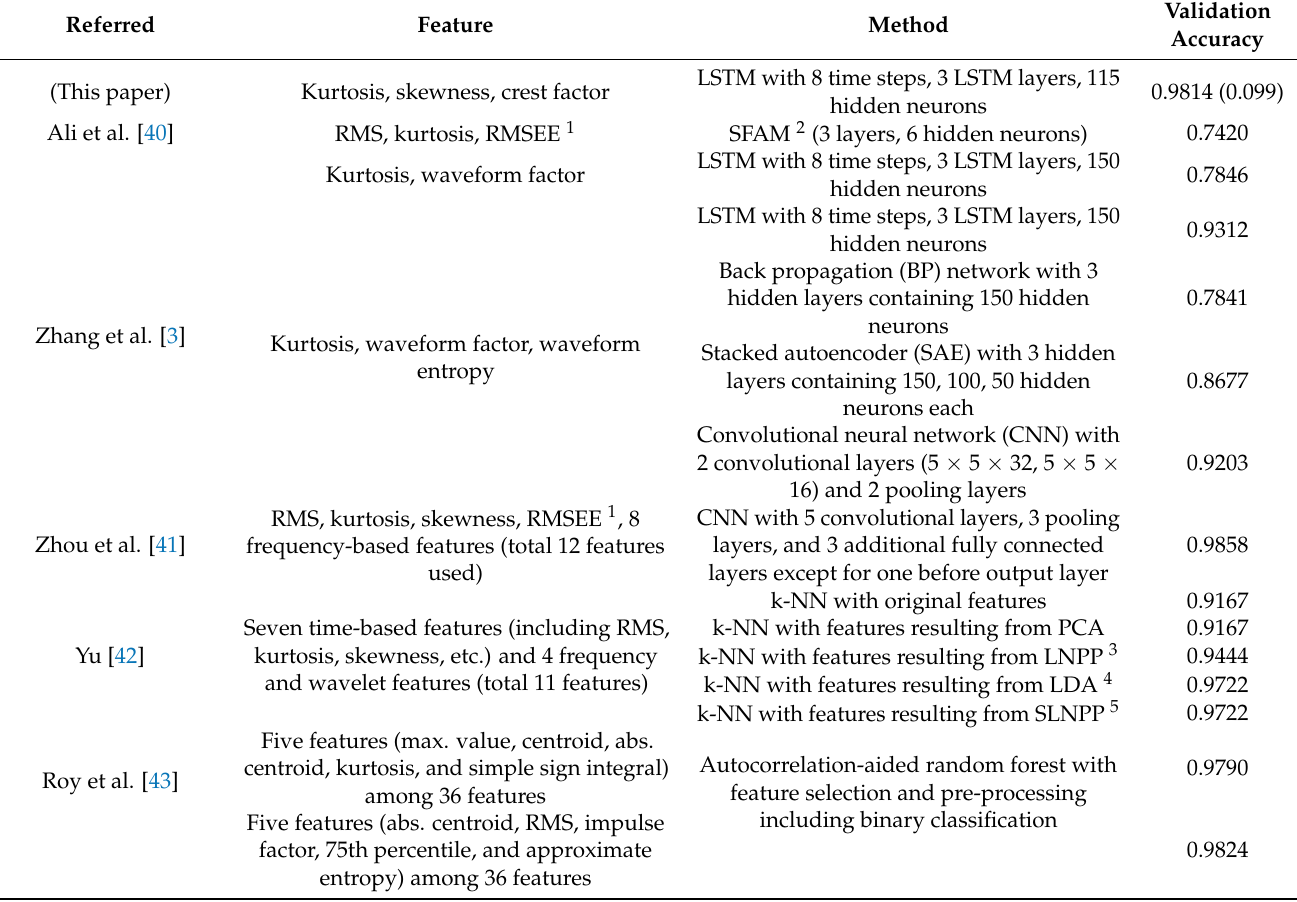
Table 5. Comparison of validation accuracy obtained from this research and